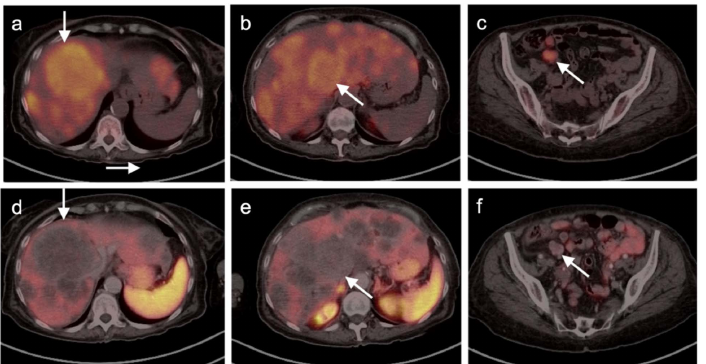
Figure 41. Comparison between FDG PET-CT ( a – c ) and [ 68 Ga]Ga-DOTA-TATE PET-CT ( d – f ) in a patient with poorly differentiated NET. ( a – c ), Axial FDG PET-CT images of the abdomen and upper pelvis show multiple hypermetabolic liver metastases (white arrows) and a hypermetabolic mesenteric mass (white arrow). ( d – f ) Axial [ 68 Ga]Ga-DOTA-TATE PET-CT images of the abdomen and upper pelvis show multiple liver metastases and the mesenteric mass with no demonstrable uptake (white arrows). This patient would not be a good candidate for Lutathera ®